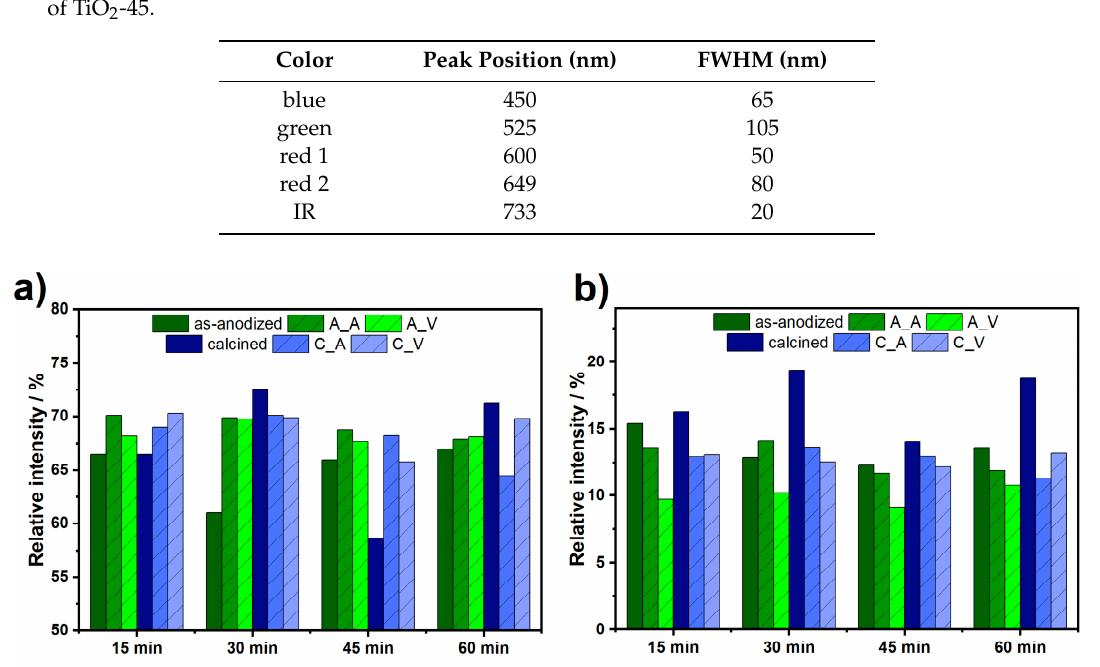
Figure 8. The relative area of the different emissions: a) green, b) red for laser annealed titania nanotubes, as well as references: as-anodized and calcined. Shortcuts: A_A, A_V, C_A, C_V mean as-anodized modified in air, as-anodized in vacuum, calcined in air, and calcined in vacuum, respectively. Table 3. The fitting parameters used to perform deconvolution of photoluminescence spectrum of TiO 2 -45.